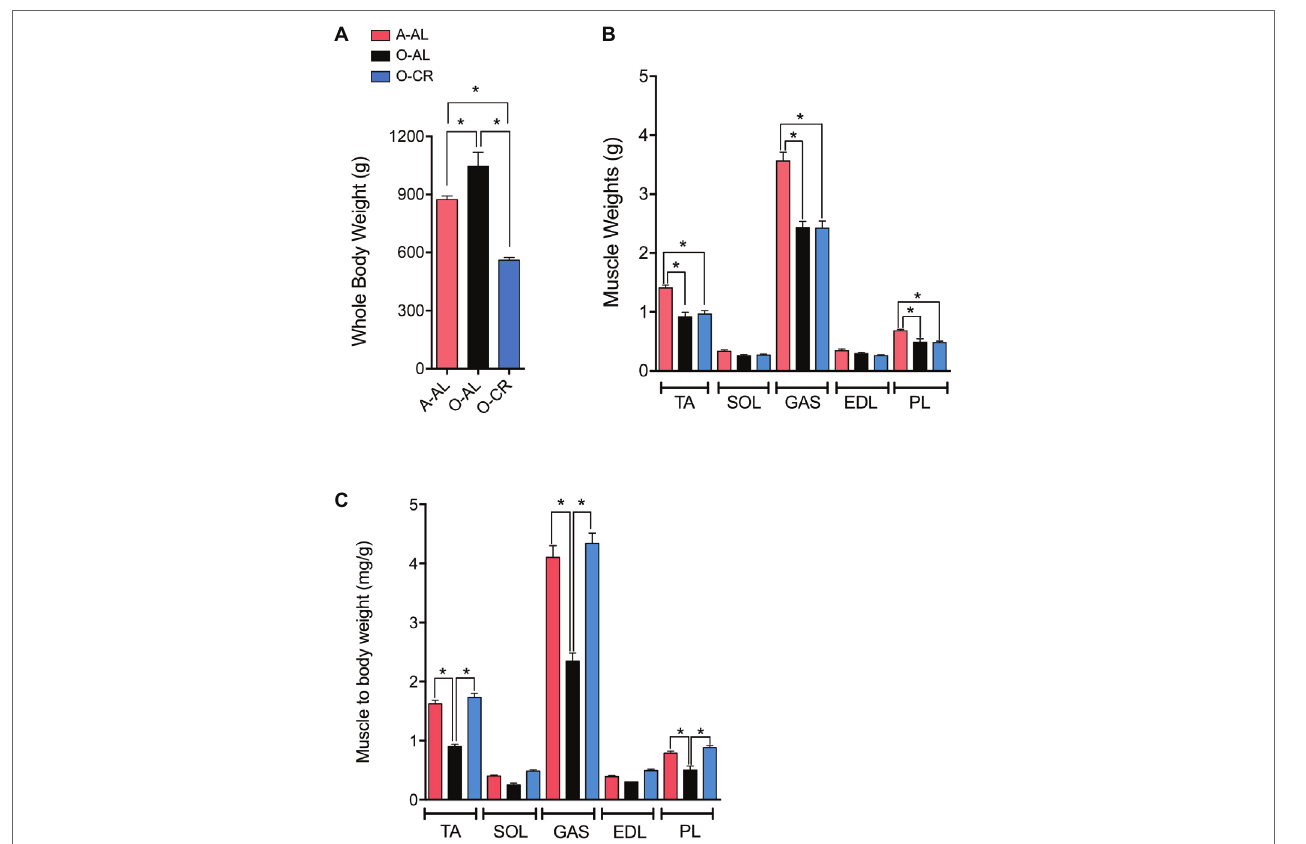
FIGURE 1 | Effect of aging and caloric restriction on body weight and muscles weight. (A) Whole body weights and (B) TA, SOL, GAS, EDL, PL muscles weights, and (C) TA, SOL, GAS, EDL and PL weight relative to body weight of adults (A-AL, N = 9), old ad libitum (O-AL, N = 4) and old CR rats (O-CR, N = 11). Data represented mean ± SEM. *: p <